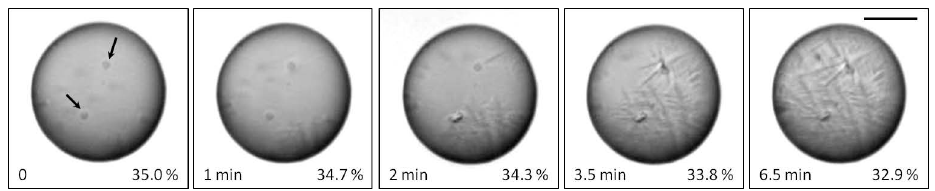
Fig. 5. Efflorescence process of a C6/AS/H 2 O particle with mf d (AS)=0.083 (OIR=11:1) from onset of efflorescence at 35.0% until the particle is fully covered by needles at 32.9%RH. Size bar: 20µm. Aqueous AS inclusions are marked by